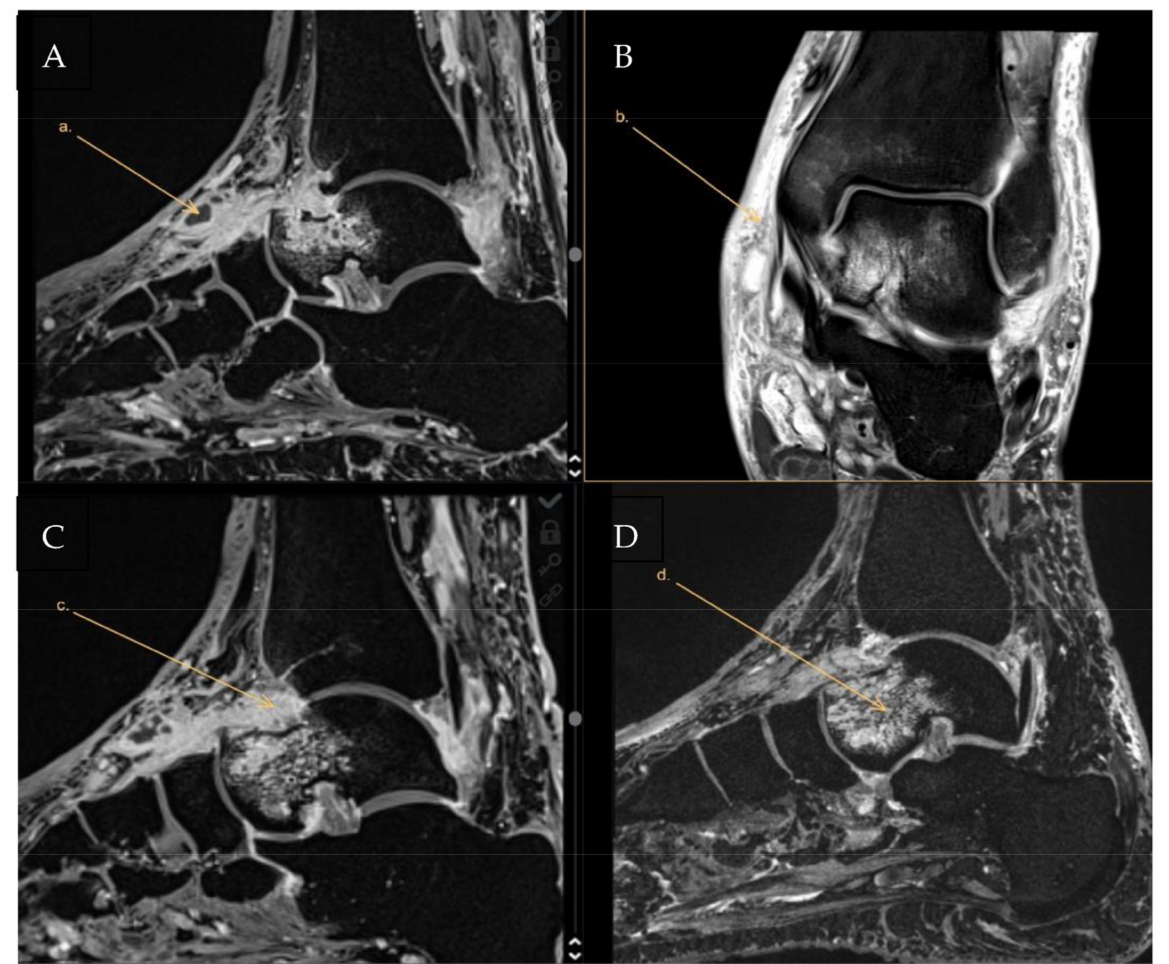
Figure 2. MRI of the affected left ankle on day 8. Arrows in the individual panels show ( A ) multiple small abscesses in the medial side of the feet, ( B ) edema of the tendons, ( C ) arthritis of the TC joint, and ( D ) osteomyelitis of the